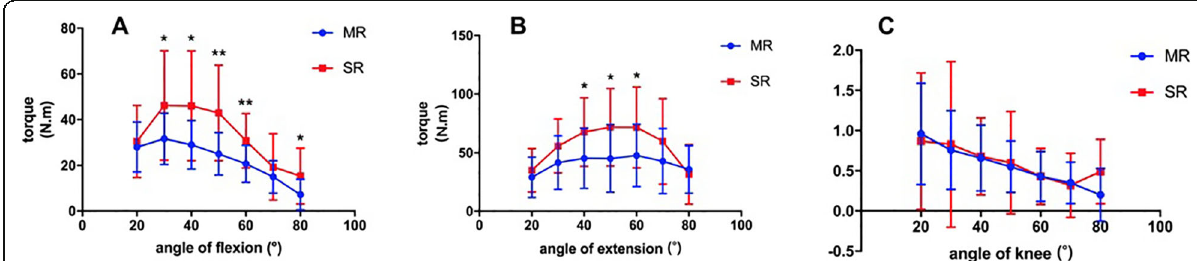
Fig. 3 Comparison of angle specific torque at 60°/s: a extension; b flexion; c H/Q ratio. * indicated P <0.05 between groups and ** indicated P <0.01 between groups. (SR: single radius, MR: multiple radius, H/Q: